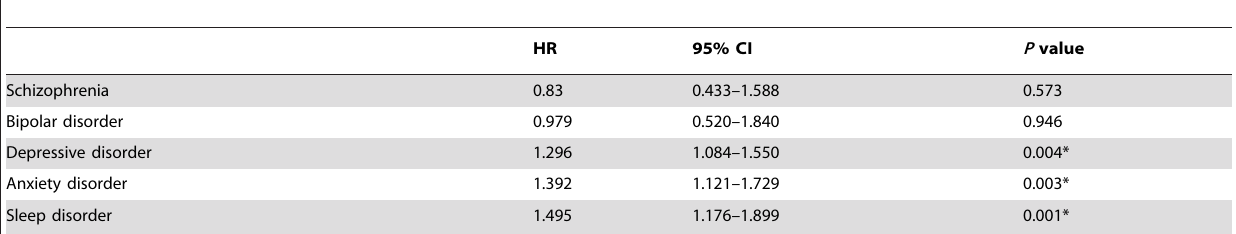
Table 2. Hazard ratios of time until psychiatric disorders between patients with polycystic ovarian syndrome (PCOS) and control subjects during a ten-year follow-up